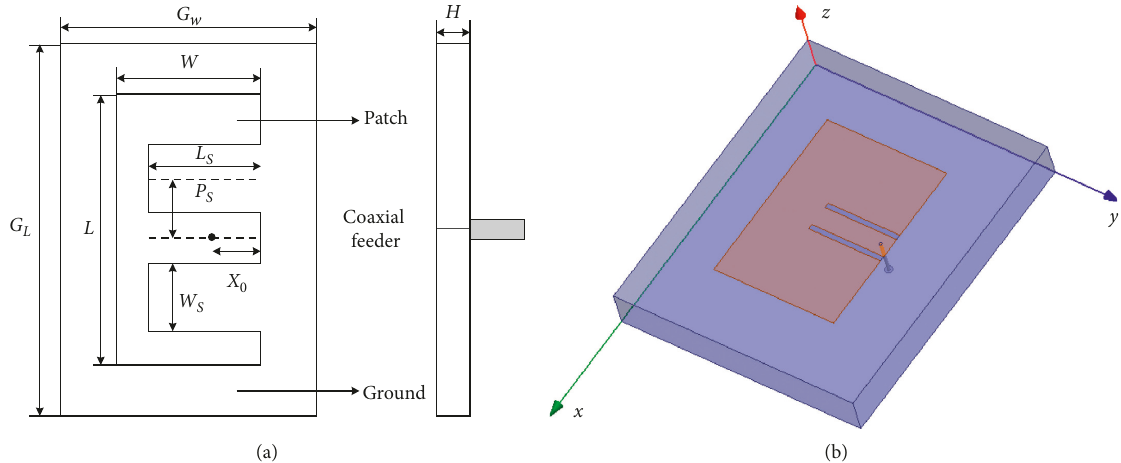
Figure 2: E-shaped dual-frequency MSA. (a) Structure of the E-shaped dual-frequency MSA. (b) E-shaped dual-frequency MSA model in HFSS.